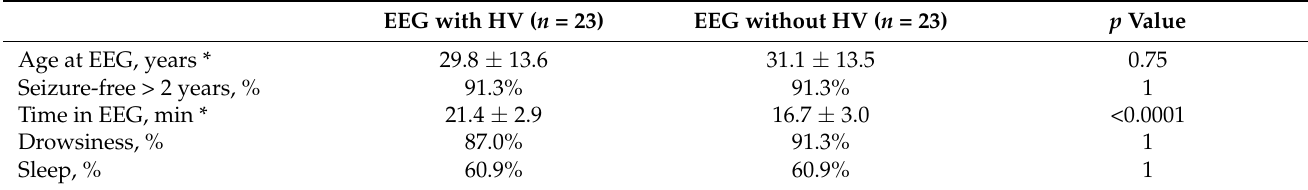
Table 1. Patient and EEG characteristics at the two EEG